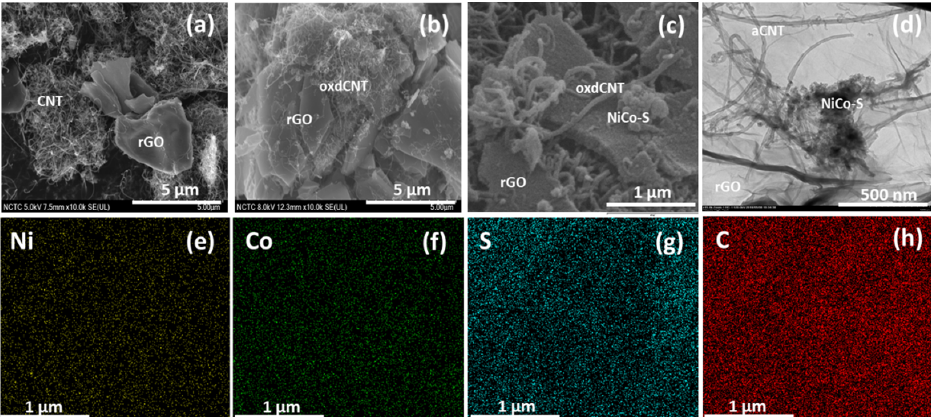
Figure 2. SEM images of rGO/CNT ( a ), rGO/oxdCNT ( b ) and (NiCo)–S@rGO/oxdCNT composite ( c ). ( d ) TEM image of (NiCo)–S@rGO/oxdCNT composite and corresponding EDS elemental mappings ( e – h ).